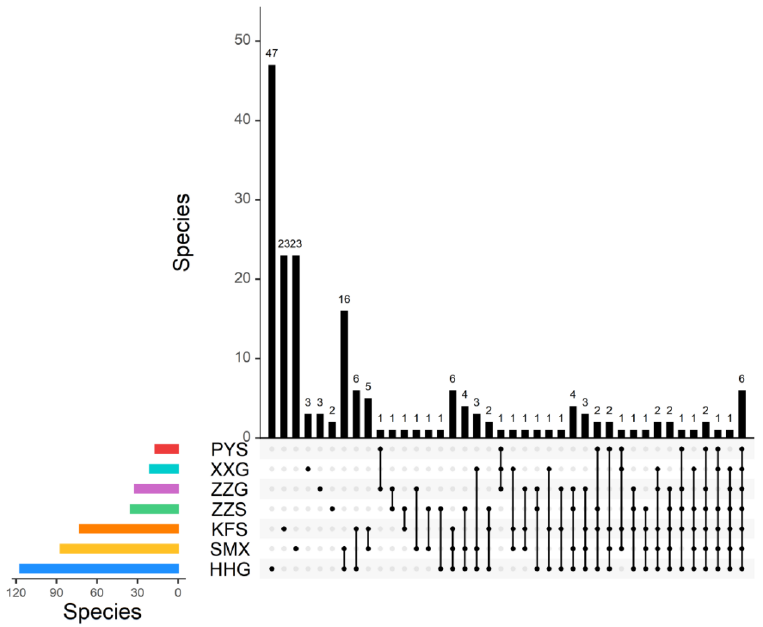
Figure 2. Venn diagram of wetland plants in the seven nature reserves of the Yellow River in Henan Province, China. HHG, Henan Yellow River wetland national nature reserve. SMX, Sanmenxia reservoir area wetland. ZZS, Henan Zhengzhou Yellow River wetland provincial nature reserve. ZZG, Henan Zhengzhou Yellow River national wetland park. KFS, Henan Kaifeng Liuyuankou wetland provincial nature reserve. XXN, Henan Xinxiang Yellow River wetland birds national nature reserve. PYS, Henan Puyang Yellow River wetland provincial nature reserve.